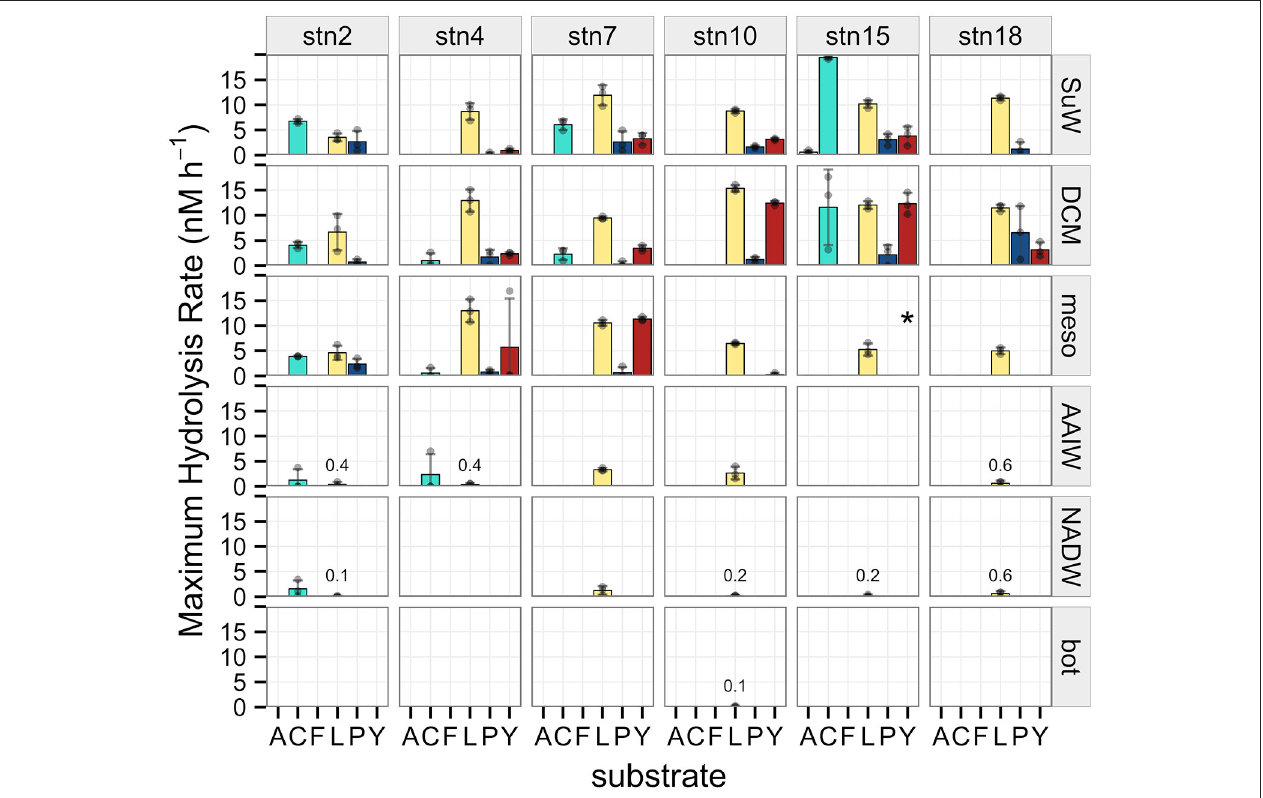
FIGURE 2 | Maximum potential hydrolysis rate (nM h − 1 ) of the six polysaccharide substrates arabinogalactan (A), chondroitin sulfate (C), fucoidan (F), laminarin (L), pullulan (P), and xylan (Y) at each station (vertical panels) and each depth (horizontal panels). Error bars indicate standard deviation of experimental triplicates. Missing data at stn 15, mesopelagic depth for the xylan substrate indicated by asterisk. Low, non-zero hydrolysis rates in deep waters indicated by numbers in the figure panel.